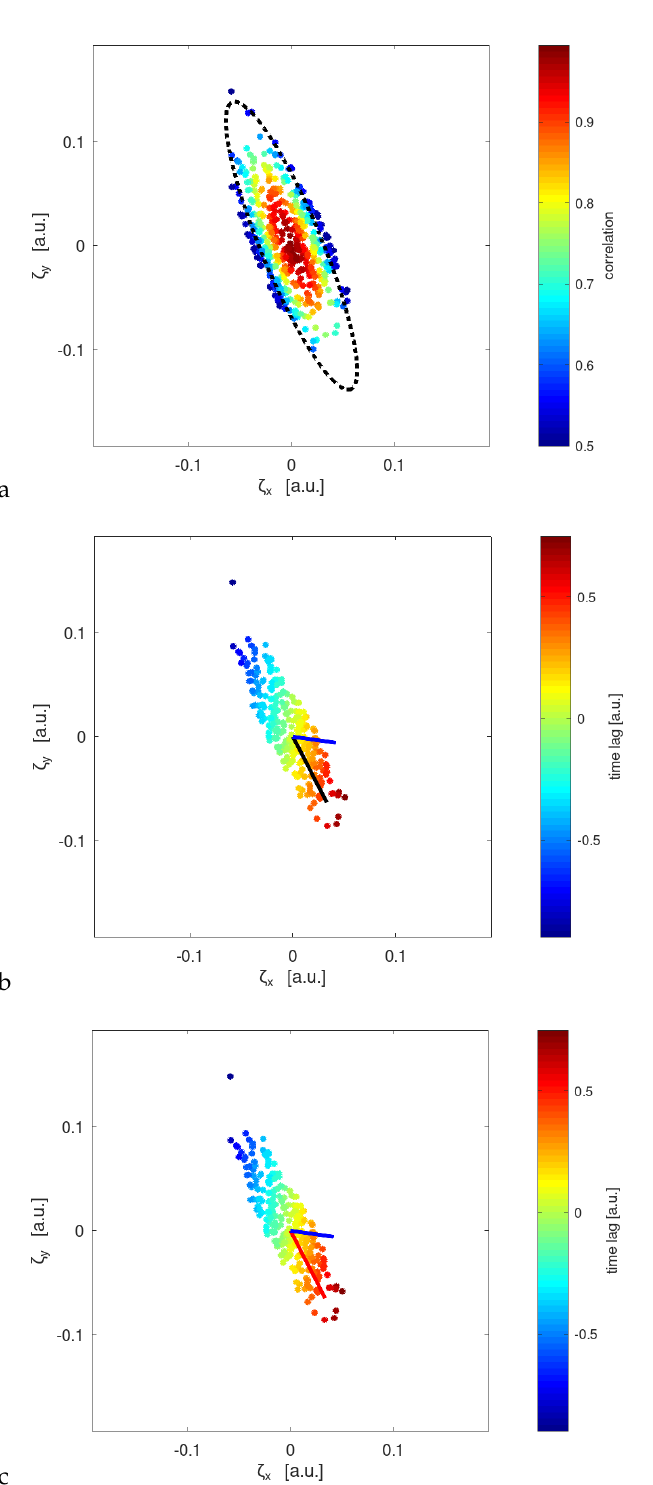
Figure 4. Colour-coded estimate of the correlation function as a function of separation—( a ), and time lag to a maximum of temporal correlation in separation coordinates, black, red and blue lines give accordingly: true velocity, velocity estimate that takes into account anisotropy of structures and isotropic velocity estimate—( b , c